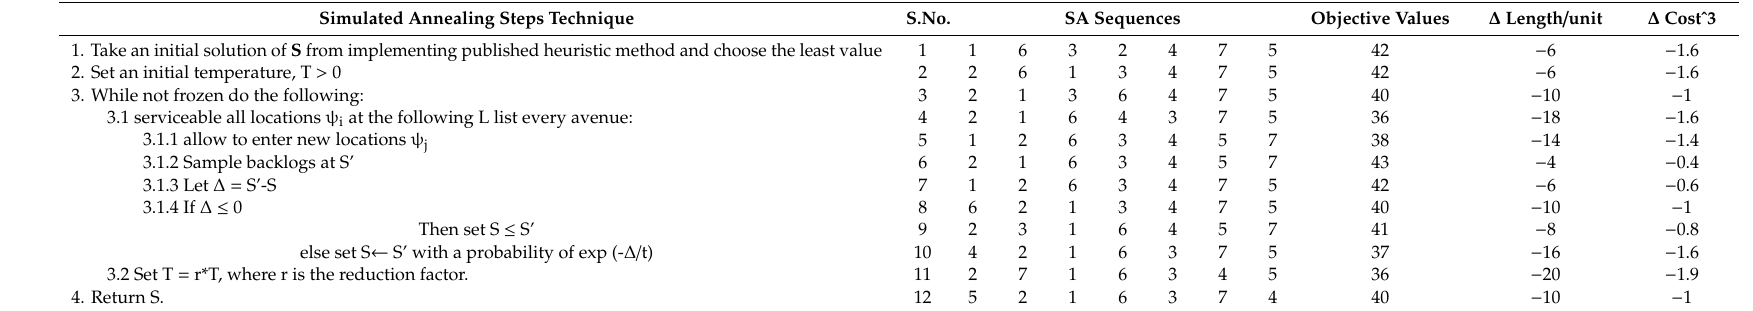
Table 2. Di ff erent sequences and objective values for bidirectional path